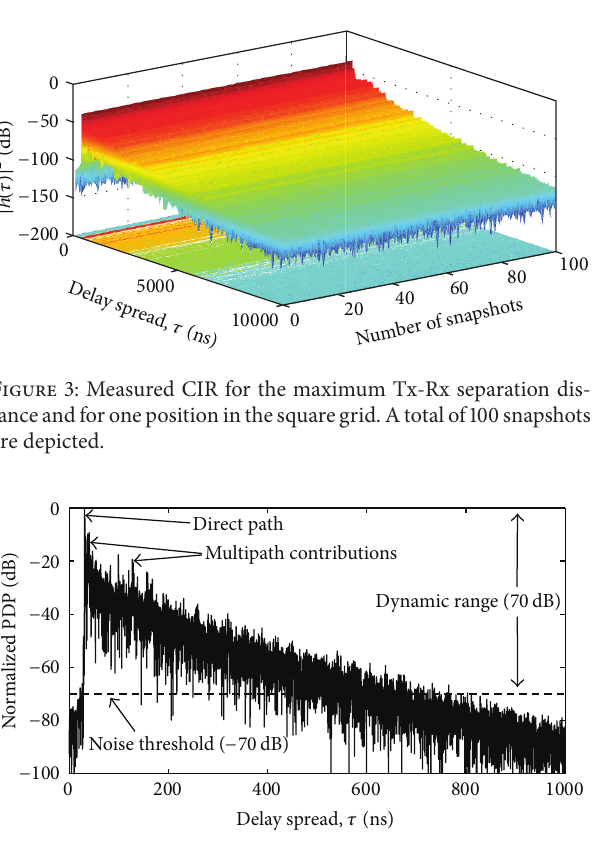
related to the propagation environment; and 𝑆 is a zero mean Gaussian random variable, with standard deviation 𝜎 𝑆 , used to model the large-scale